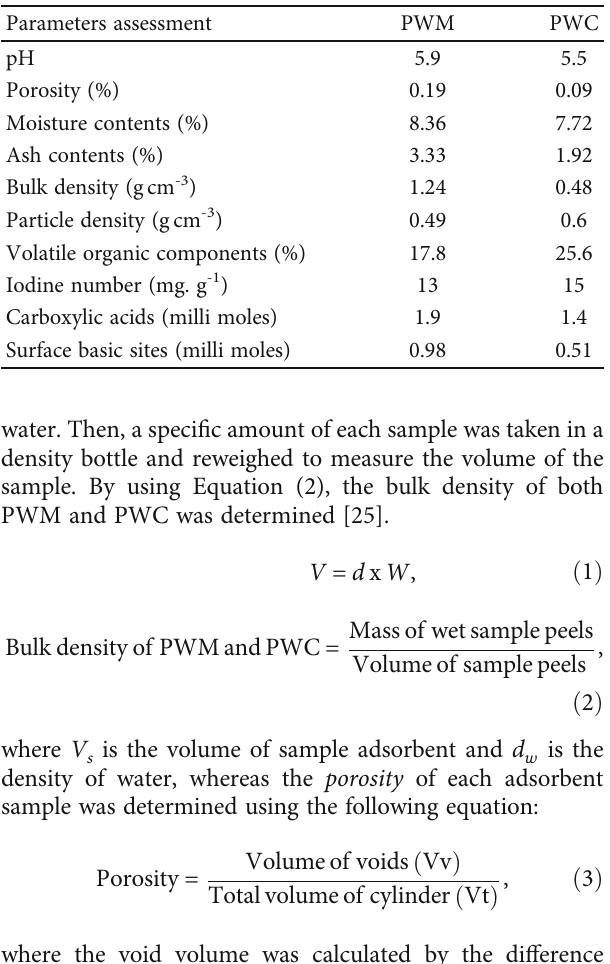
Carbon from water hyacinth leaf